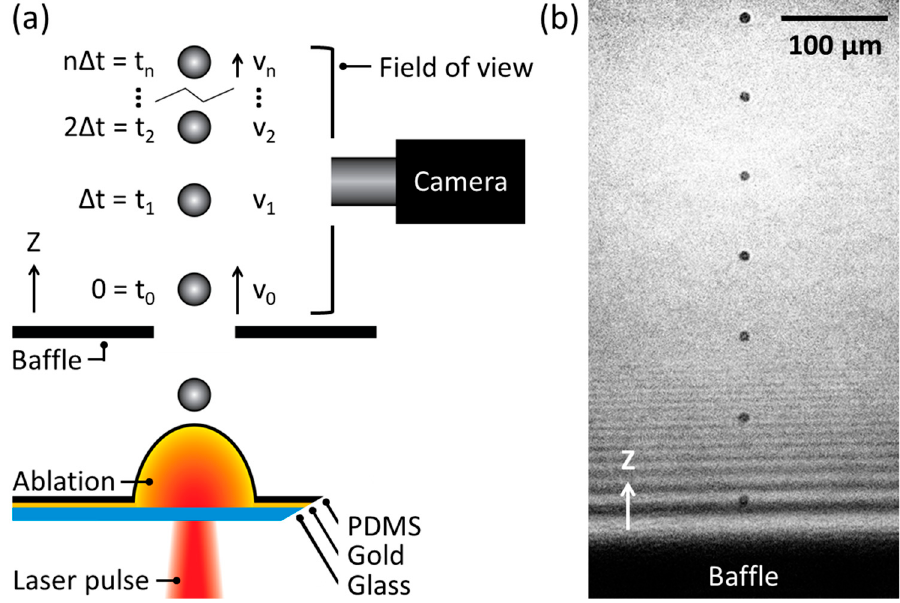
Figure 1. ( a ) Schematic of LIPIT experiment ( b ) Ultrafast stroboscopic image of microsphere trajectory ( ∆ t = 640 ns, D p = 7.6 µ m).